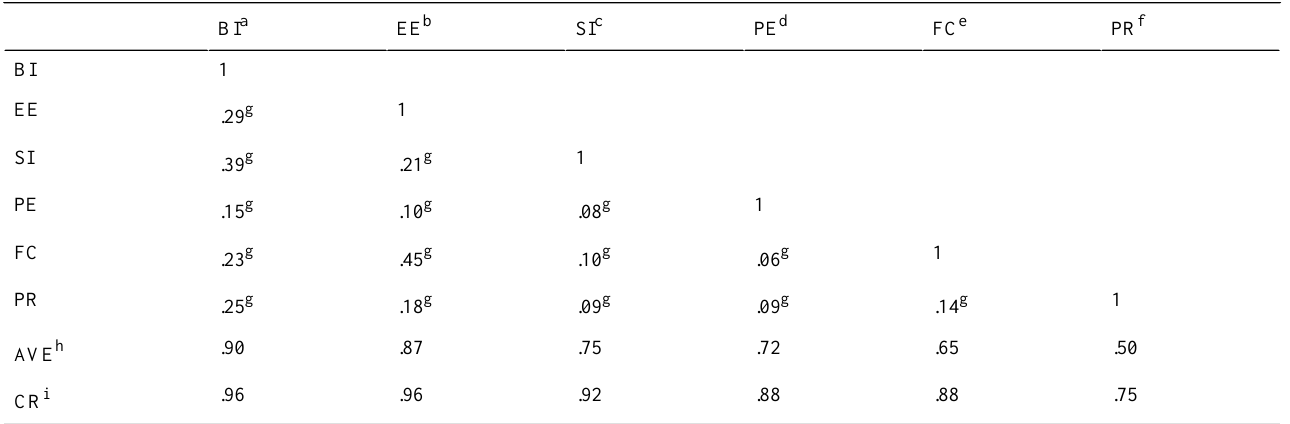
Table 6. Discriminant validity